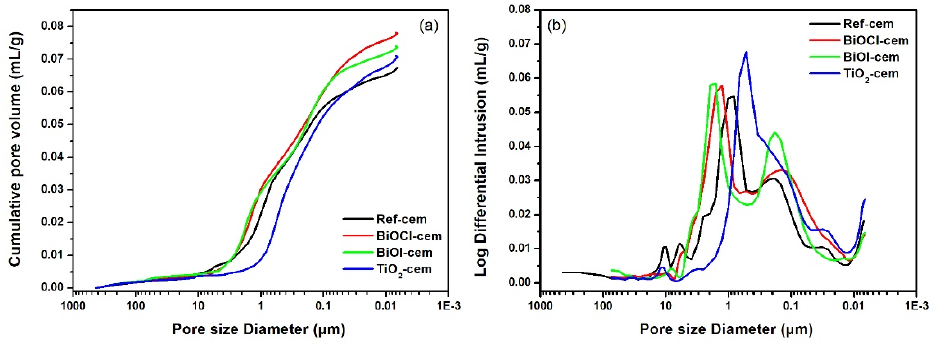
Figure 9. ( a ) Cumulative curves of the pore size distribution and ( b ) log differential intrusion with pore size diameter of the photocatalytic cement-based samples obtained by MIP.